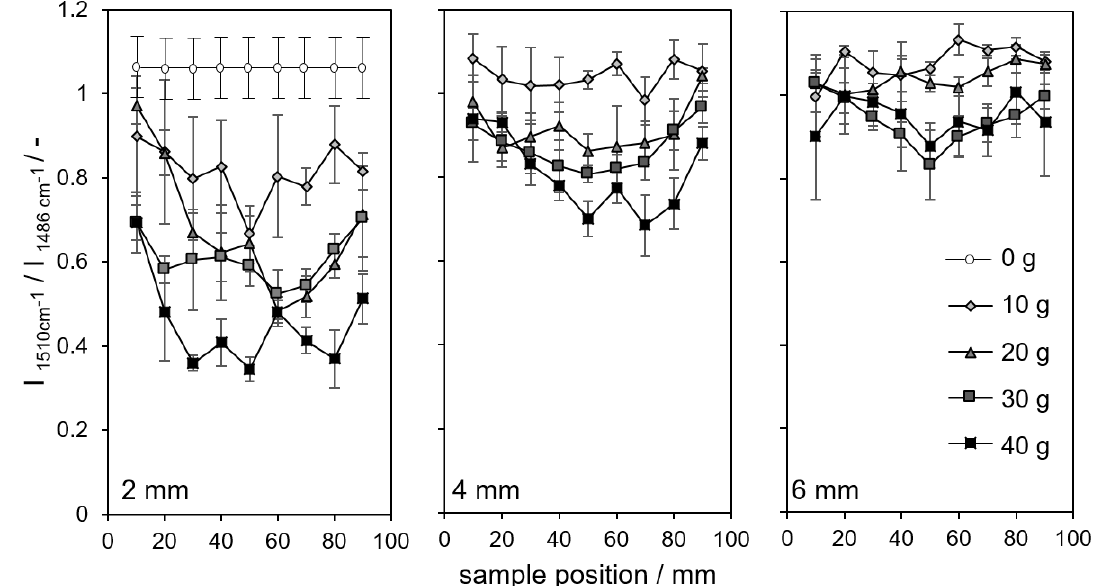
Figure 11. Representative distribution of the intensity ratios of bands characteristic for EP (1510 cm − 1 ) and PES (1486 cm − 1 ) after impact of various amounts of fire accelerants on 2, 4, and 6 mm thick 8552/IM7 samples (with integrated copper mesh), recorded at the backsides (horizontally aligned).